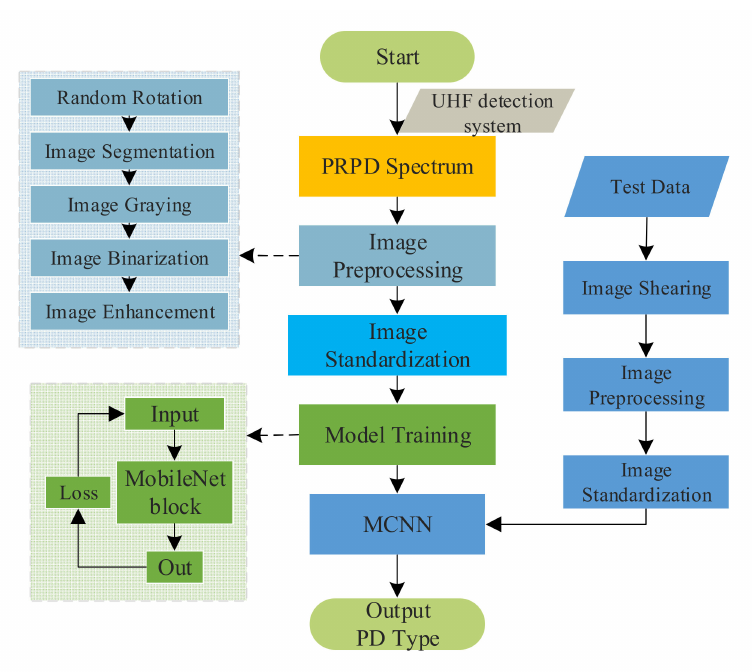
Figure 5. Structural Diagram of MobileNets Block.